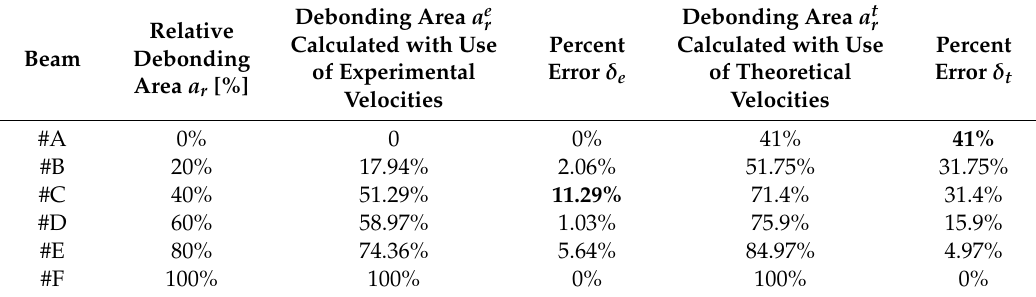
Table 2. Calculation of debonding area using theoretical and experimental